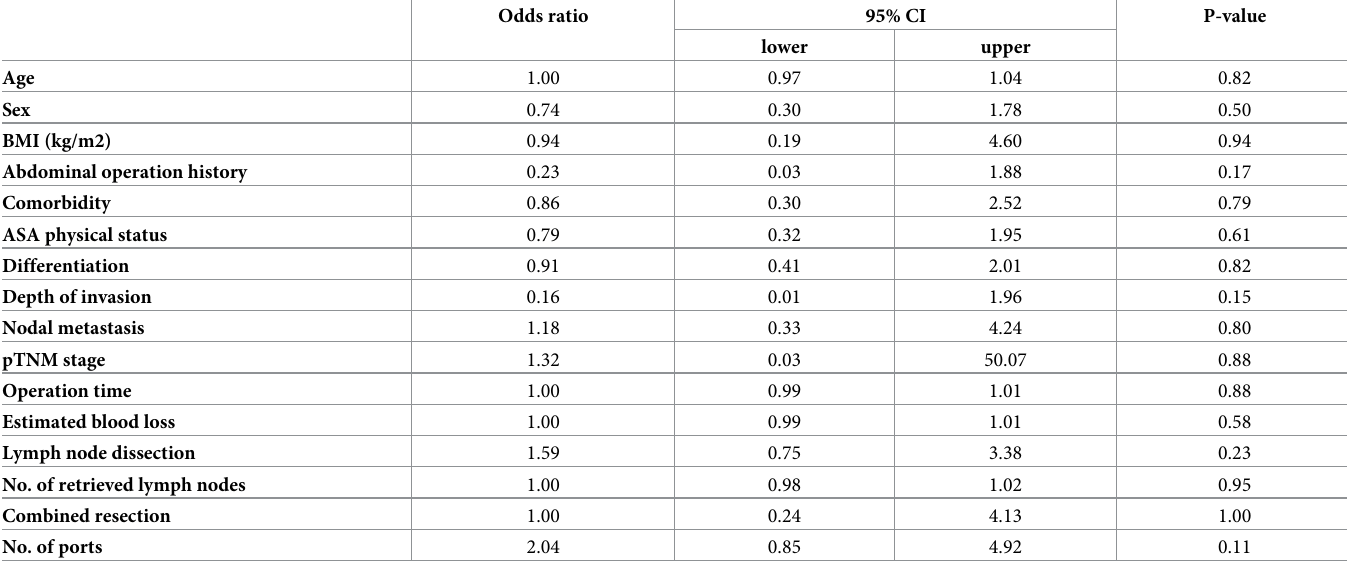
Table 5. Multivariate logistic regression analysis of surgical